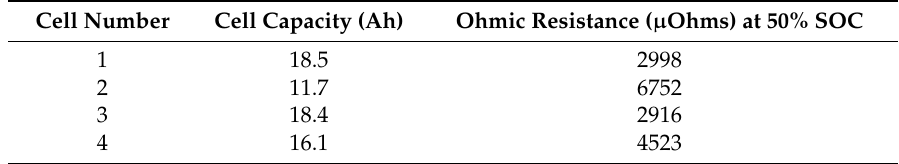
Table 1. Capacity and ohmic resistance of the four lithium iron phosphate (LFP) cells used in this study. Cell